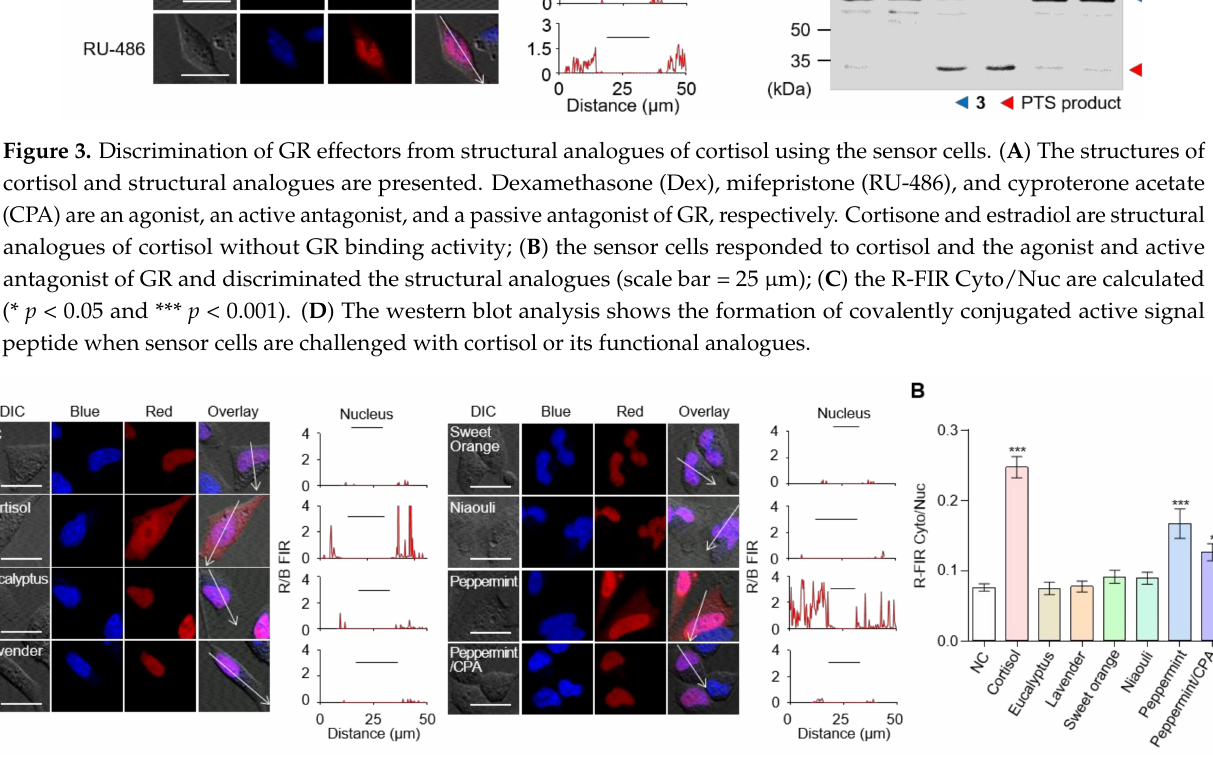
Figure 4. Screening for GR effectors in essential oil extracts. ( A ) The sensor cells were treated with 5 different essential oil extracts. Sensor cells treated with peppermint oil showed red fluorescence translocation which was repressed by co-treatment with CPA (scale bar = 25 µ m); ( B ) the R-FIR Cyto/Nuc are calculated (* p < 0.05 and *** p <